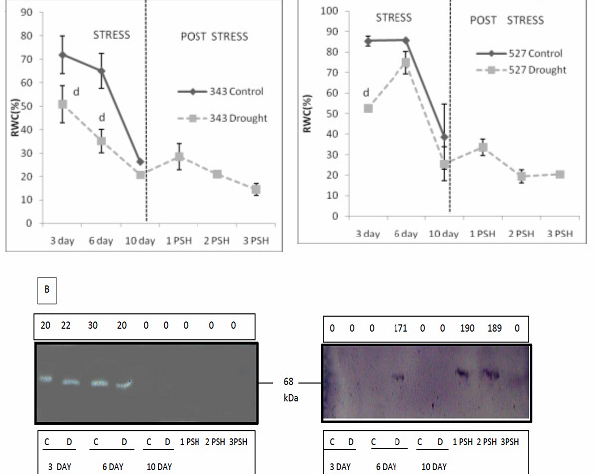
Fig. 6 : Kinetics of RWC (A) and Immuno-blot analysis of boiling soluble proteins (B) using antiserum against APase in seeds of drought tolerant (‘PBW 527 ’ ) and drought sensitive (‘PBW 343 ’ ) cultivars of T. aestivum under control and drought stress conditions harvested at different time intervals. Numerical values as shown in the top of panels indicates relative band intensities which were determined using Gel visualisation, Documentation and Analysis system (Bio-Rad, USA). PSH: Post Stress Harvest, C: control, D: drought